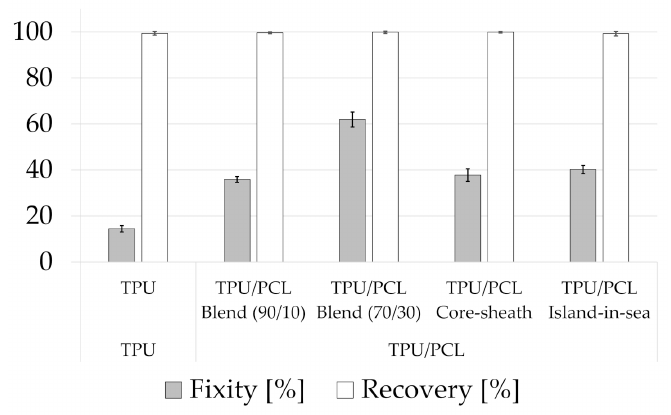
Figure 5. Stress-strain curve of a TPU only yarn sample ( a ) and a TPU / PCL blend 70 / 30 yarn sample ( b ); 4 cycles (n = 4), horizontal line represents force threshold of 0.6 MPa for determination of the fixed strain e f and the recovered strain e p .